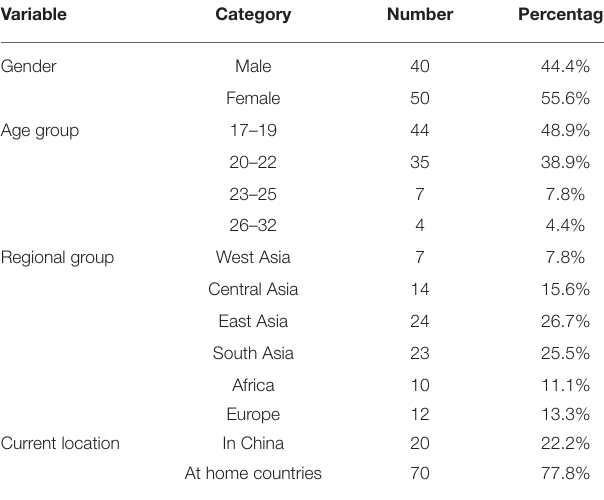
TABLE 1 | Socio-demographical information of the participants ( N =